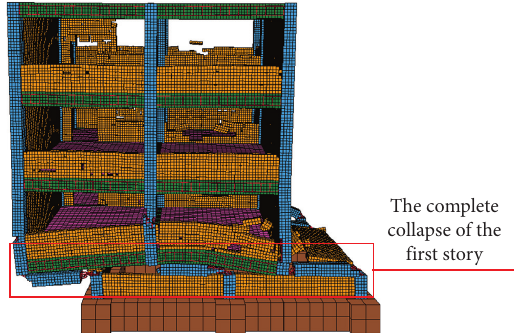
Figure 31: First-floor collapse of the simulation (front).